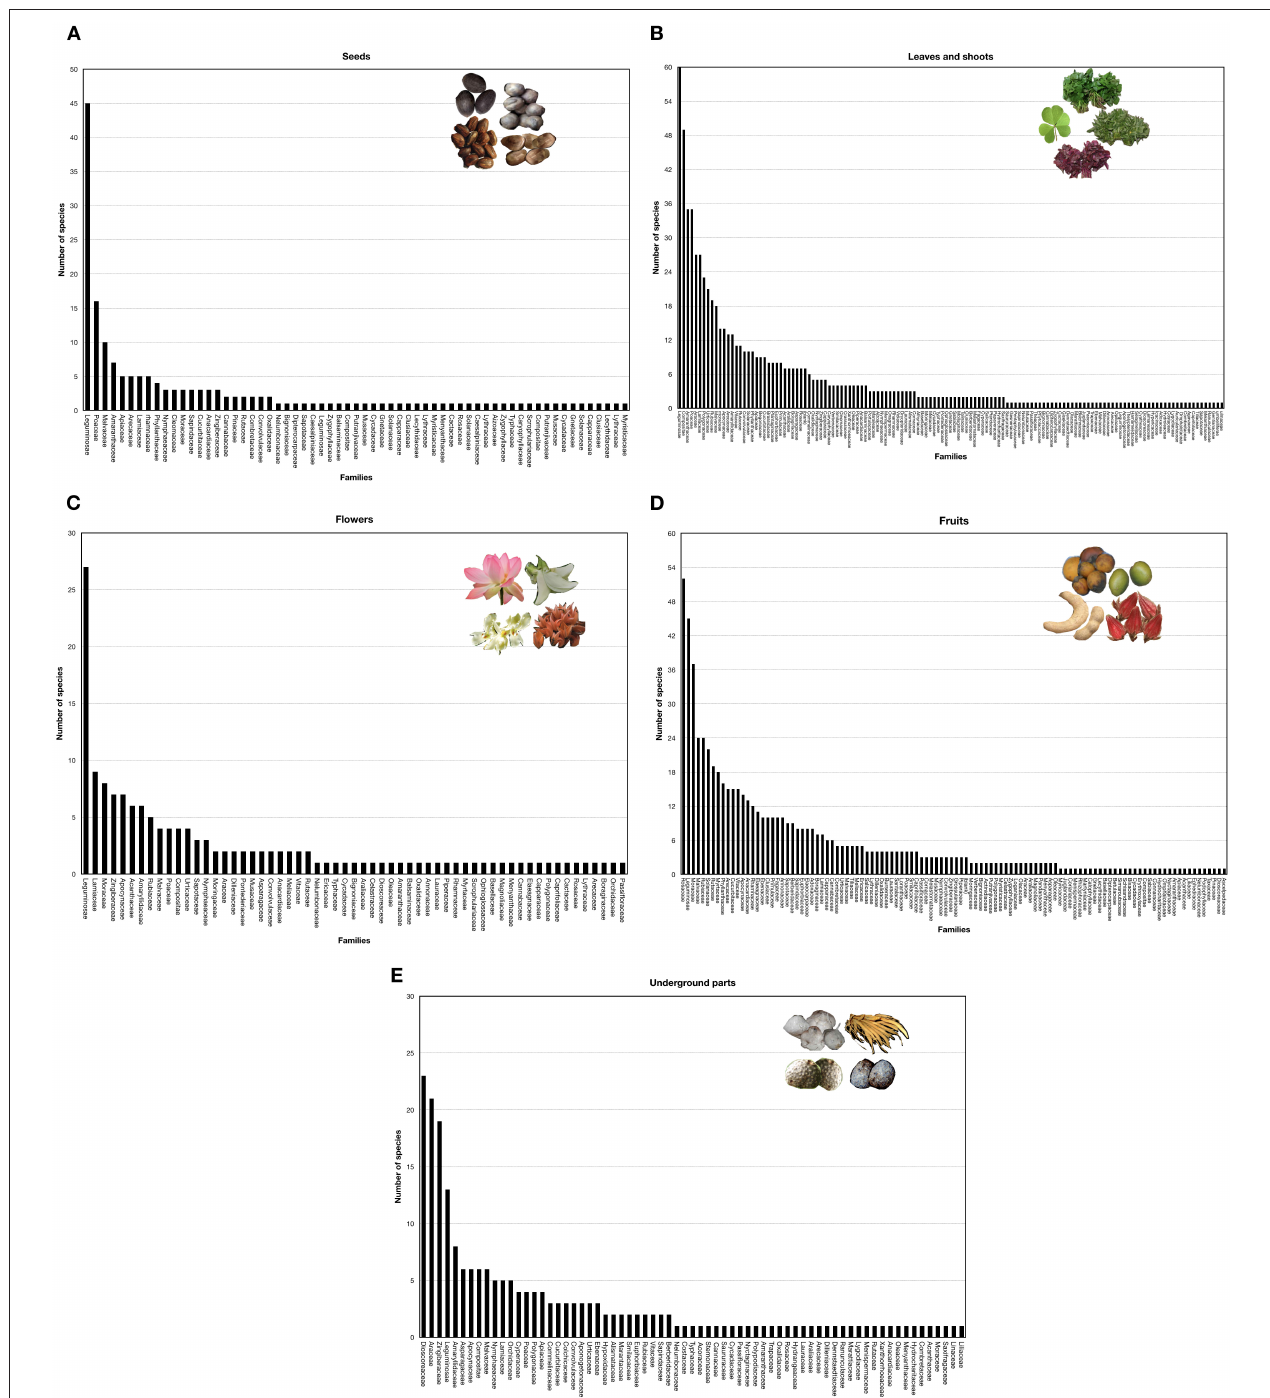
FIGURE 4 | Distribution of species across families based on individual edible plant part: (A) seeds, (B) leaves and leafy shoots, (C) flowers, (D) fruits, and (E) underground parts.